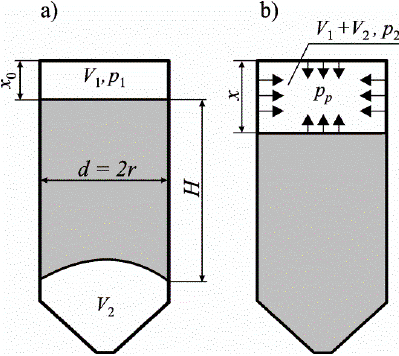
Fig. 5. Assumptions made for calculation of impacts produced by arch removal, according to Hotała (2003): a) situation before arch removal; b) situation after arch removal